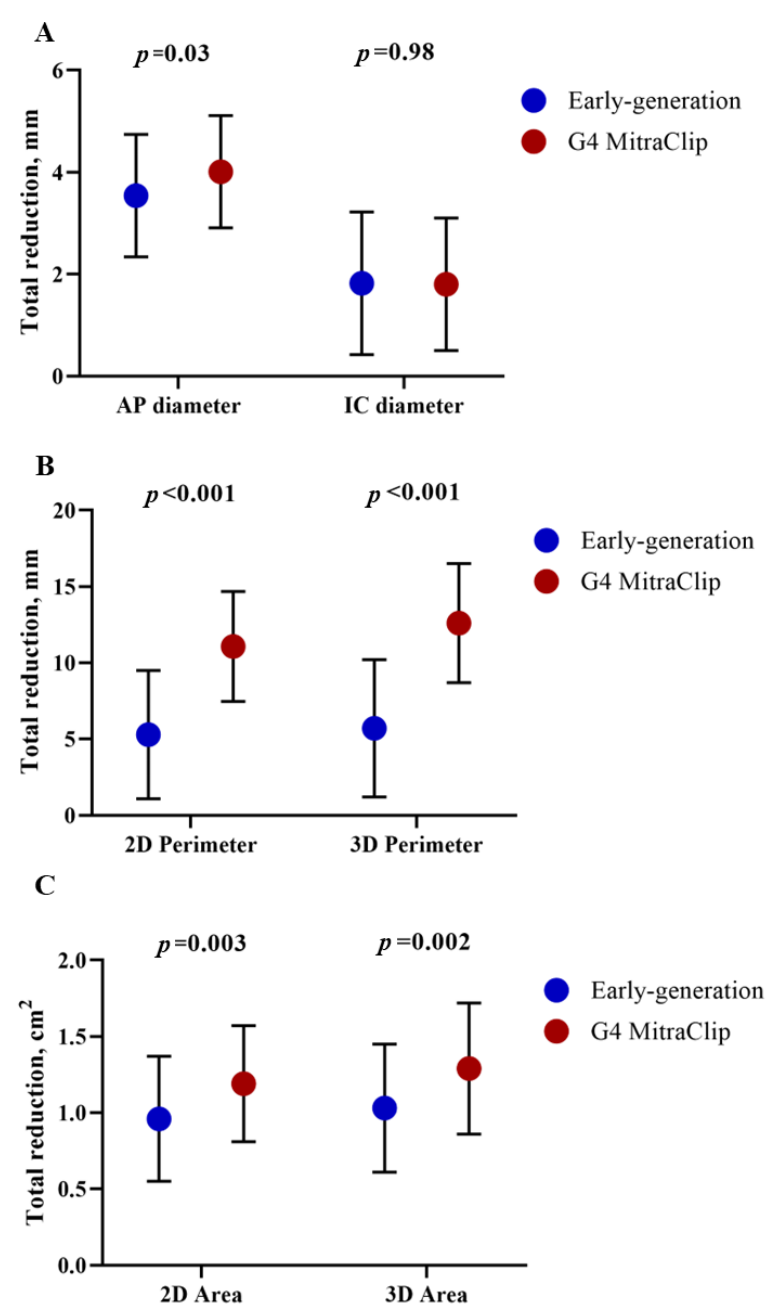
Figure 2. Delta change of mitral valve diameters ( A ), perimeters ( B ), and areas ( C ) after TEER compared to baseline according to the use of early-generation (blue dots) or 4th-generation (red dots) device systems. Error bars represent standard deviation.